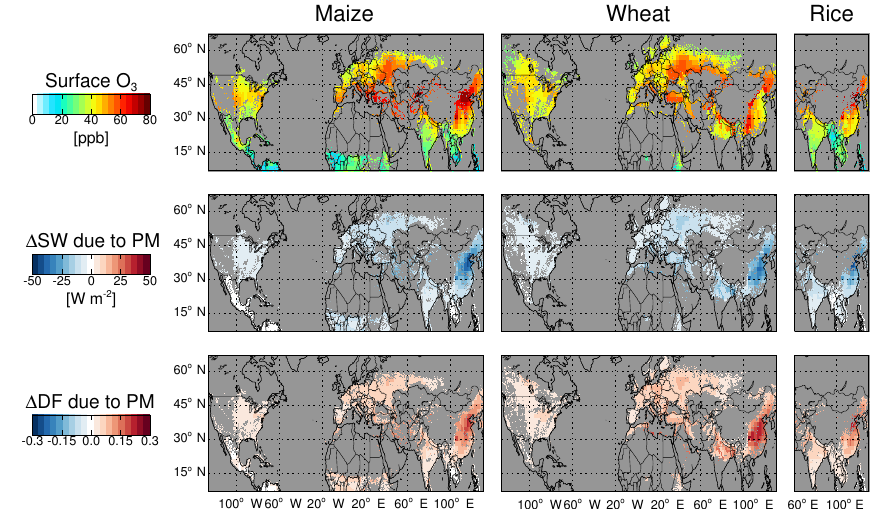
Figure 5. (top row) Mean daytime (08:00–20:00 local time) GEOS-Chem simulated surface ozone concentrations. Mean change in daytime (SW > 0) (middle row) downward SW radiation and (bottom row) DF of the SW radiation at the surface due to PM from GC-RT. Sampled to growing season ending in 2010 for (left column) maize, (middle column) wheat, and (right column) rice. Filtered for base crop production greater than 0.01Mgkm − 2 .